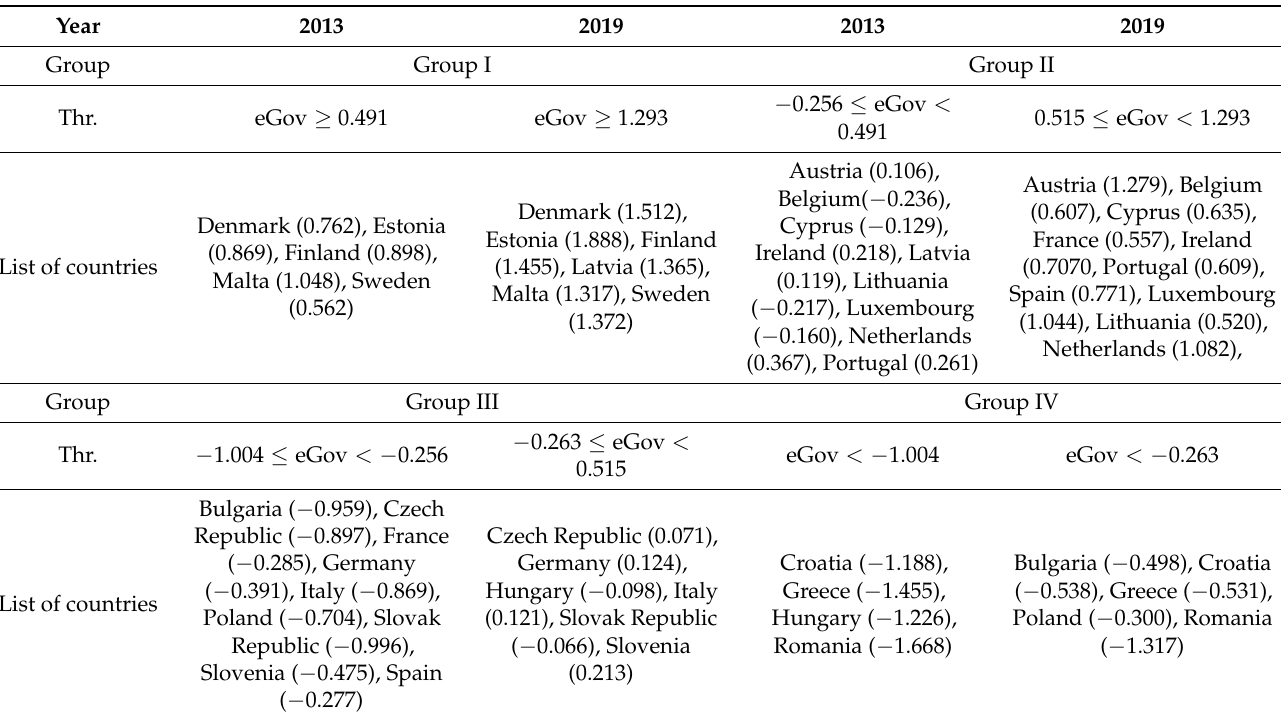
Figure 1. The results of the synthetic index of evaluating e-government services’ development for EU countries in 2013–2019. Table 2. The findings of countries’ grouping on the synthetic index of e-government services’ development for 2013 and